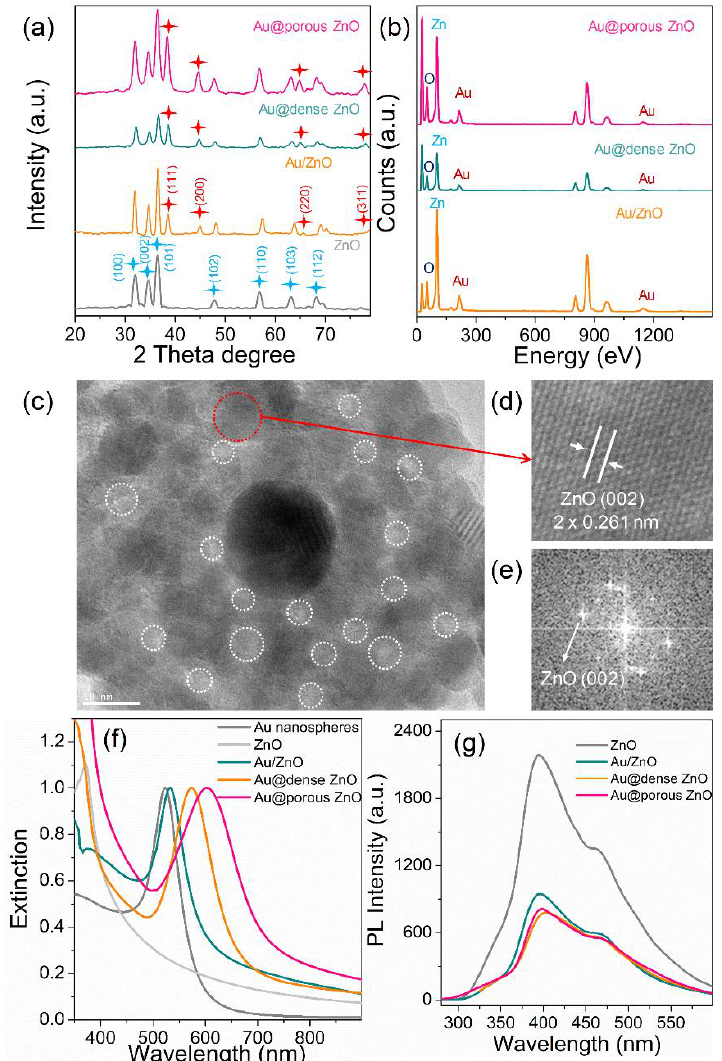
Figure 2. XRD patterns ( a ) and EDS spectra ( b ) of the structure-adjustable Au-ZnO hybrids. ( c ) High-resolution TEM (HRTEM) image of Au@porous ZnO. ( d ) HRTEM image recorded from the area marked with a red circle in ( c ). ( e ) Fast Fourier transform (FFT) pattern of the region indicated by a red dashed circle. ( f ) Extinction spectra of Au, ZnO, and structure-adjustable Au-ZnO hybrids. ( g ) Photoluminescence (PL) spectra of ZnO and the structure-adjustable Au-ZnO hybrids.